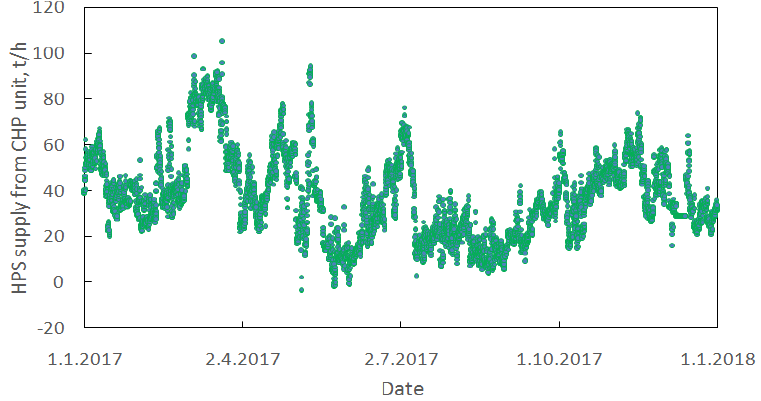
Figure 4. The amount of HPS supplied from the combined heat and power (CHP) unit during year 2017. Table 6. Selected model parameters and HPS supply into the steam network.